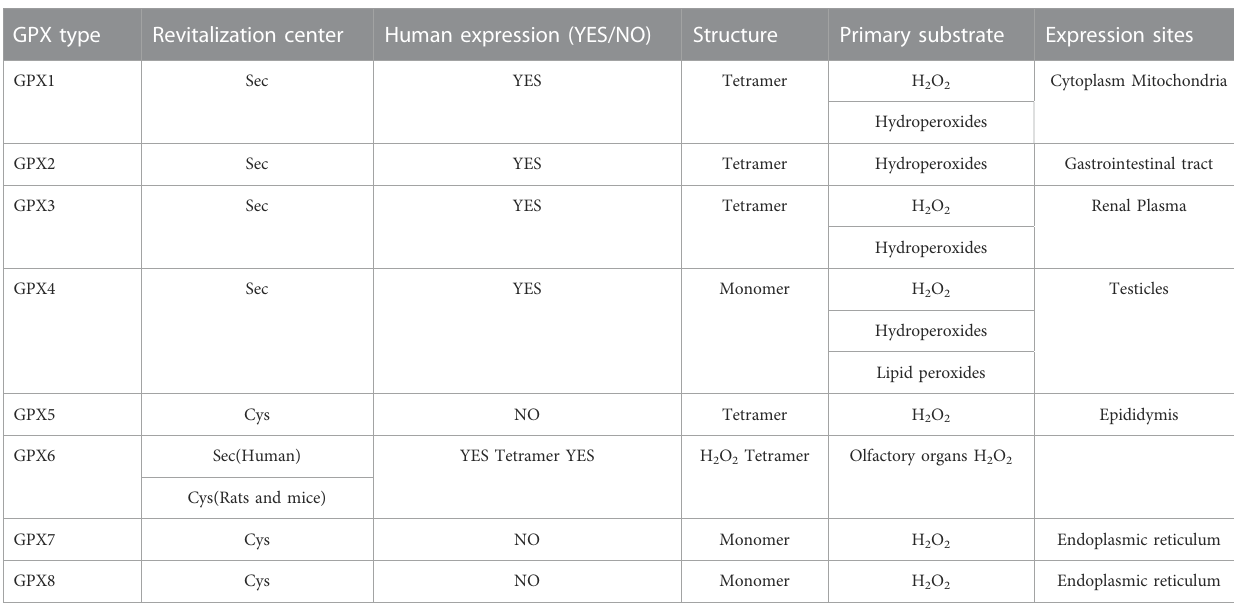
TABLE 1 GPX family structural